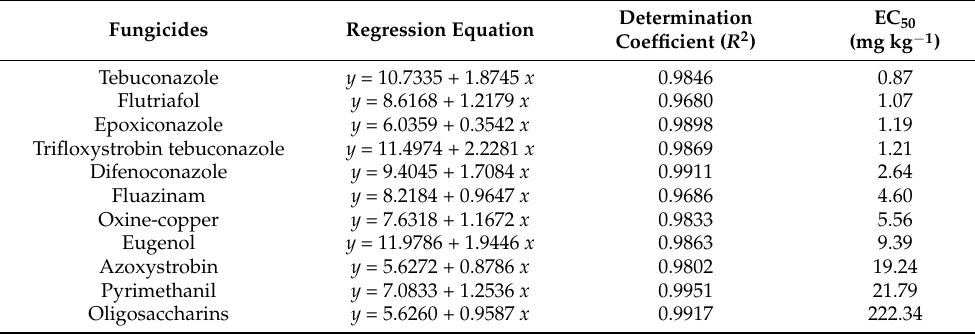
Table 3. The toxicities of different fungicides on B. dothidea RF-1.